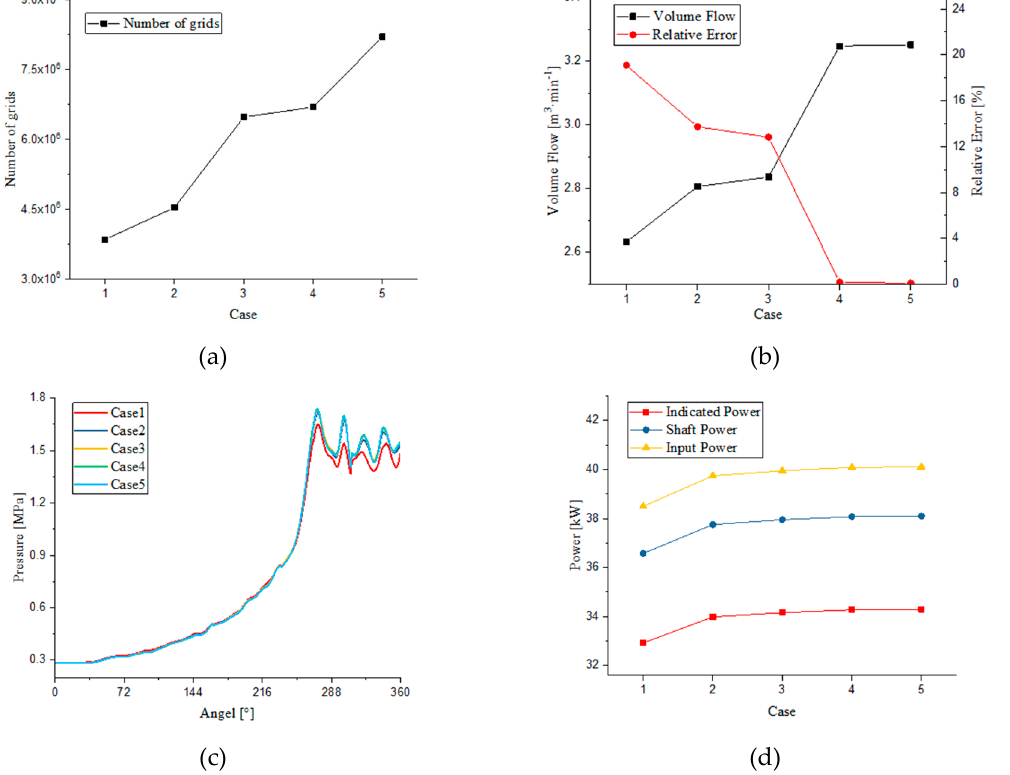
Figure 4. Mesh independence verification. ( a ) Mesh numbers in different cases. ( b ) Volume flow in different cases. ( c ) P- θ diagram in different cases. ( d ) Power in different cases.